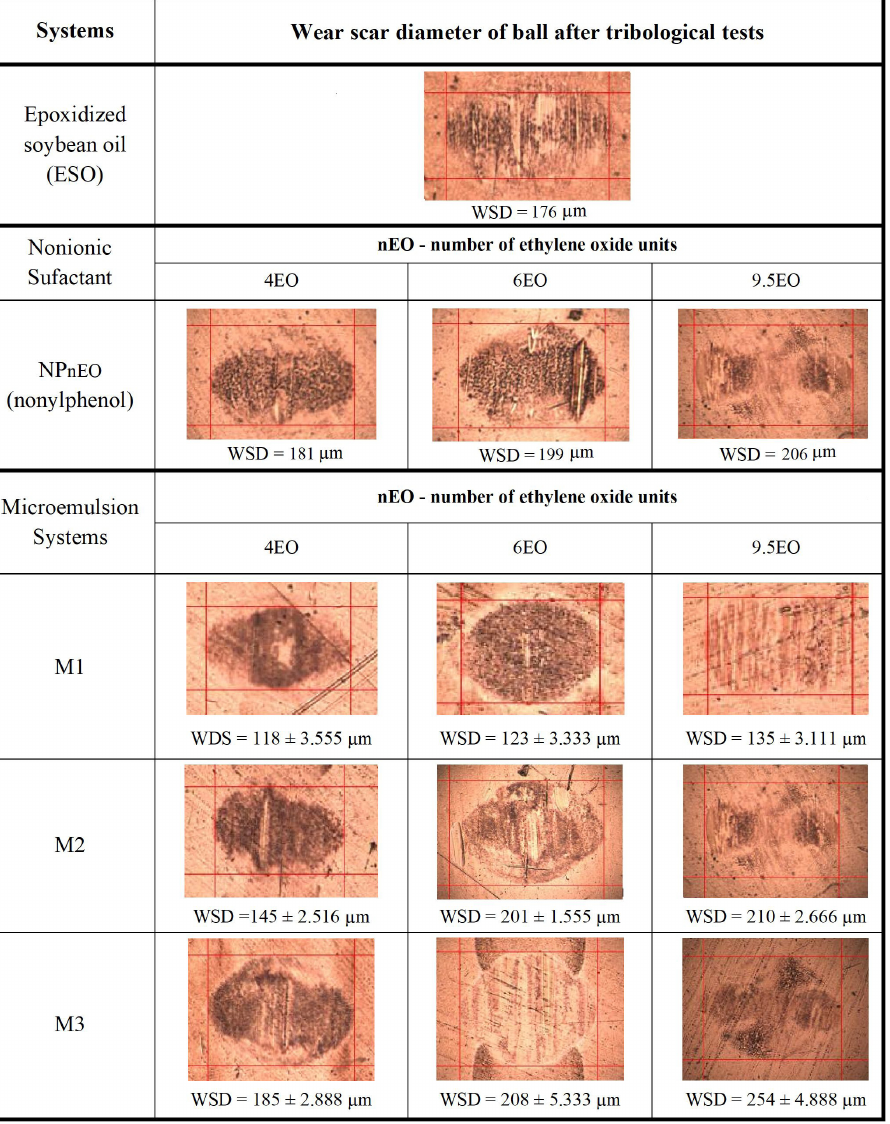
Figure 8. Images of wear scar on steel ball AISI 5210. The average scar diameter for epoxidized soybean oil (ESO), ethoxylated nonionic surfactants (NP4EO, NP6EO and NP9.5EO) and microemulsion systems (M1, M2 and